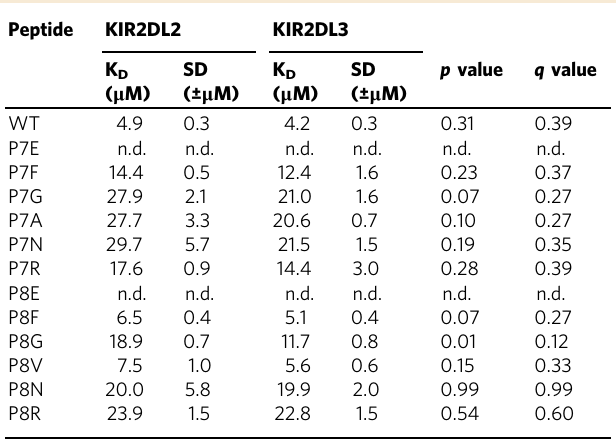
Table 1 KIR2DL2 and KIR2DL3 binding to HLA-C*07:02- RL9-P7/P8 mutant peptide panel.